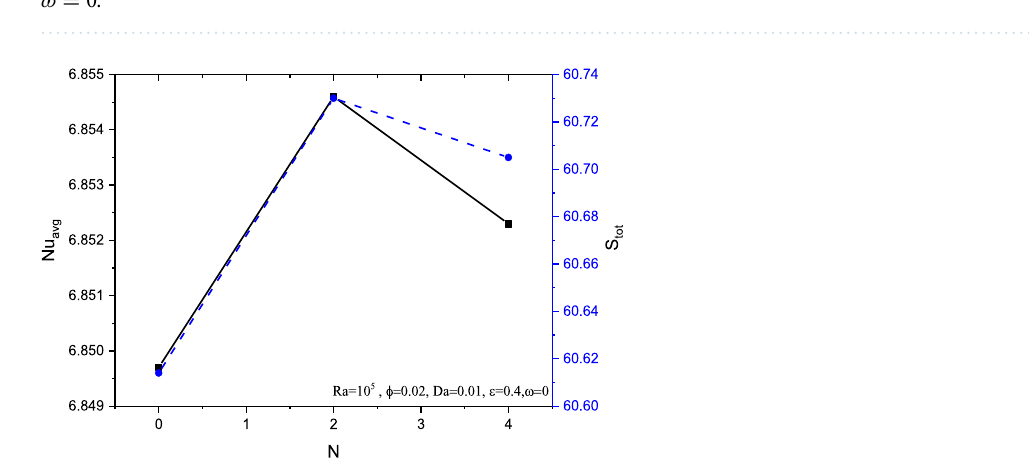
10 5 , Ha 0 , ω 0 , Da 0.01 and = = = =